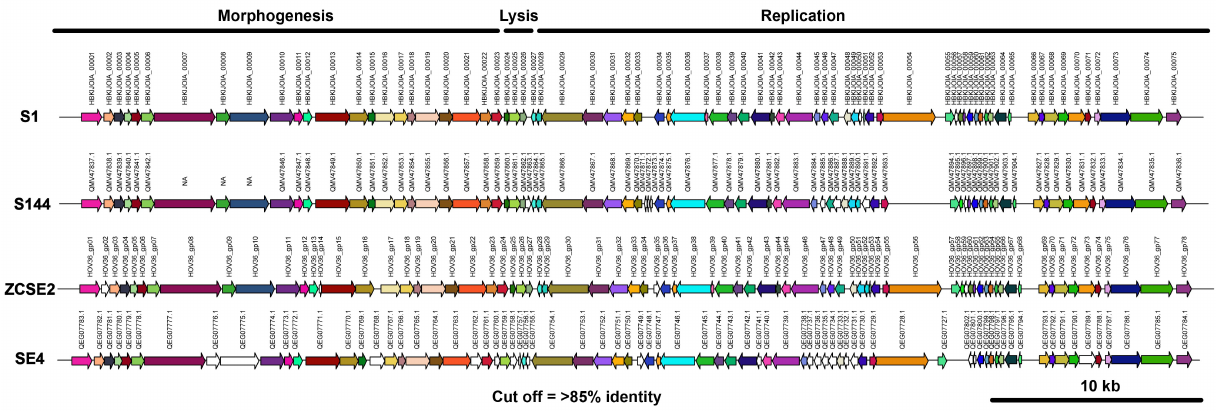
Figure 3. Genome alignment of viral proteins sharing >85% identity in phages from the genus Loughboroughvirus . From top to the bottom, the figures show phage S1, ZCSE2, S144 and SE4. ORF’s are shown with arrows and the number of each ORF is indicated on top of the arrow. Arrows with the same colors among all of them represent homologous proteins sharing >85% identity, otherwise they are shown in white. Arrows to the right indicate forward sense, arrows to the left indicate reverse sense.